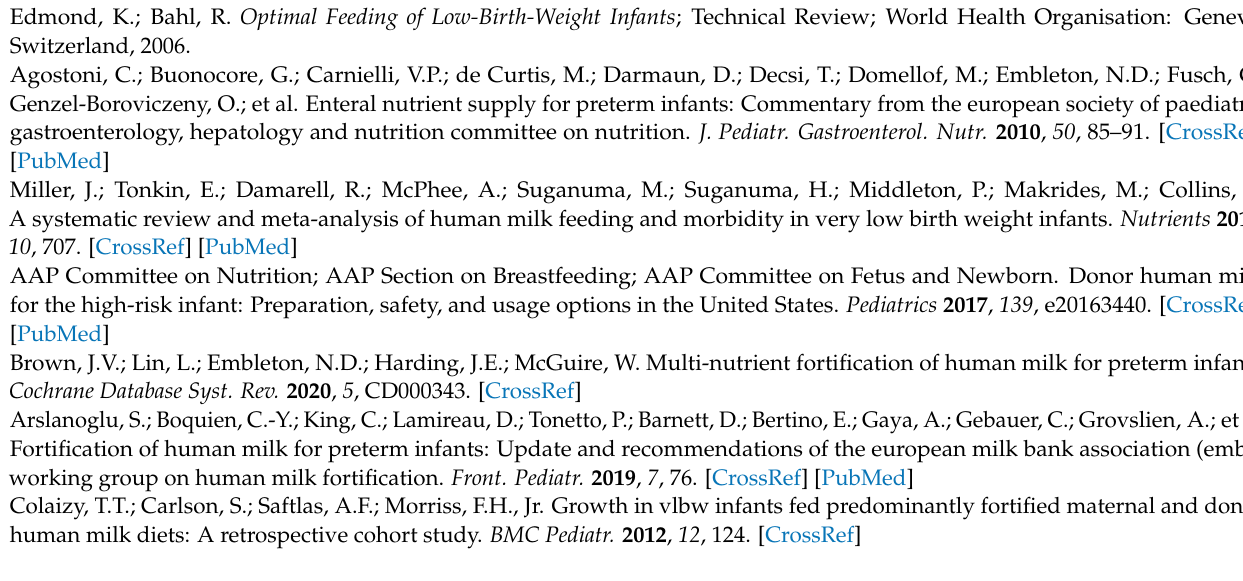
Preterm formula vs. Human milk—% fat mass, Table S12: Summary of findings: Preterm formula vs. Human milk—Fat mass